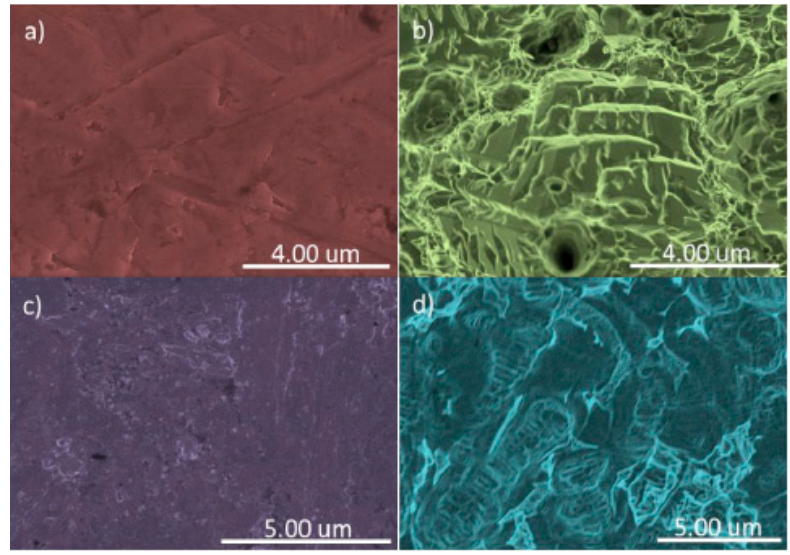
Figure 6. SEM images of the untreated with TiO 2 film. ( a ) Grade IV non-SLA sample; ( b ) Treated (SLA) grade IV; ( c ) Untreated (non-SLA) grade V; ( d ) Treated (SLA) grade V.